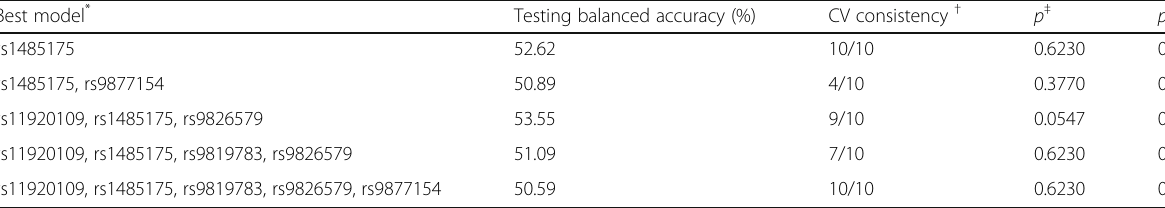
Table 5 Results of the best model identified by GMDR Best model * Testing balanced accuracy